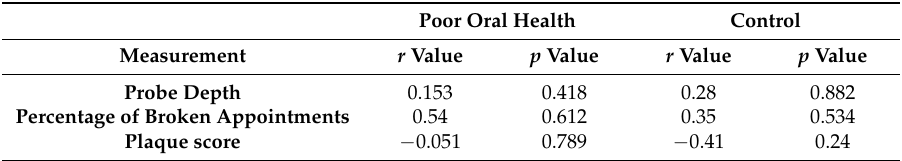
Table 4. Dental characteristics. Probe depth was not significantly associated with plaque score, frequency of visits, nor were these dental characteristics different between